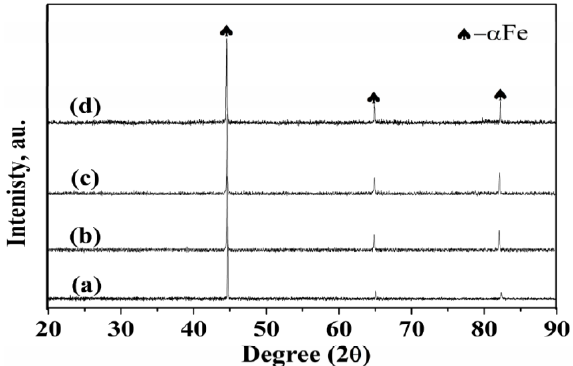
Figure 7. X-Ray Diffraction (XRD) results on the surface of the ternary Fe-28Mn-3Si alloys sintered at 1200 °C for different isothermal holding times. ( a ) MM alloys without isothermal holding; ( b ) MM alloys with 1 h isothermal holding; ( c ) MM alloys with 2 h isothermal holding; ( d ) MM alloys with 3 h isothermal holding. Metals 2017 , 7 , 81